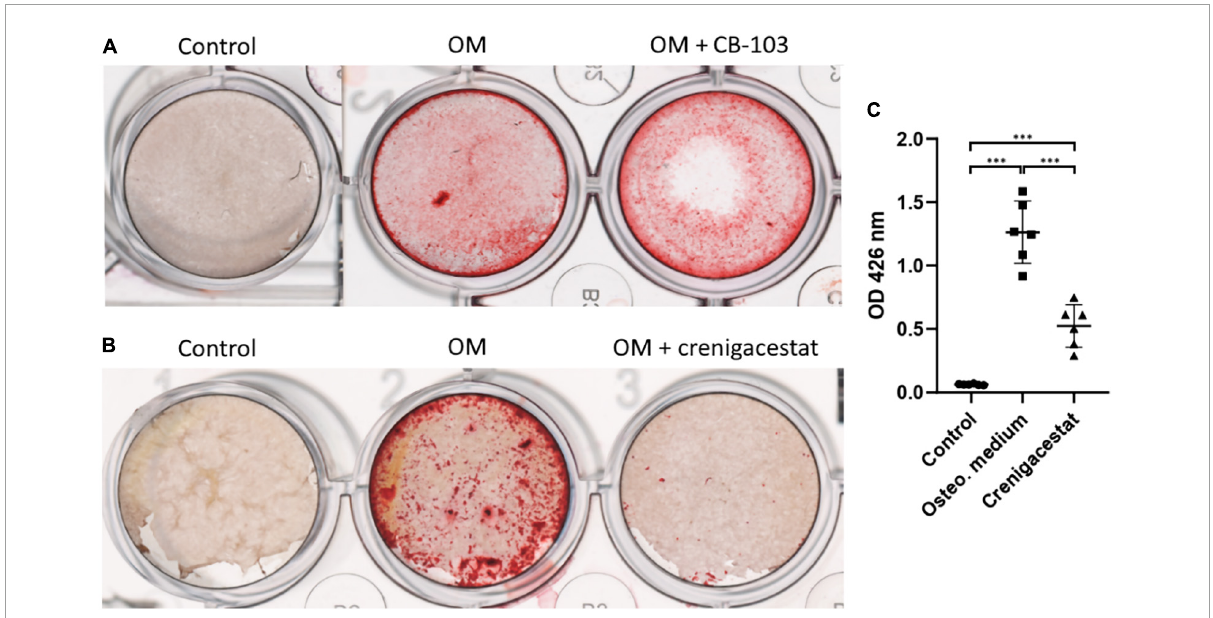
FIGURE1 Effect of CB-103 and crenigacestat (LY3039478) on osteogenic differentiation of human valve interstitial cells (VICs) in vitro . (A) Alizarin Red stain of VICs in control, osteogenic medium (OM), and osteogenic medium supplemented with 100 nM of CB-103 (OM + CB-103). (B) Alizarin Red stain of VICs in control, osteogenic medium (OM), and osteogenic medium supplemented with 100 nM of crenigacestat (OM + crenigacestat). (C) Quantitative measurement of Alizarin Red stain by spectrophotometry of VICs in control, osteogenic medium (OM), and osteogenic medium supplemented with crenigacestat (OM + cre.). Groups are compared using ANOVA, ∗∗∗ P < 0.001.